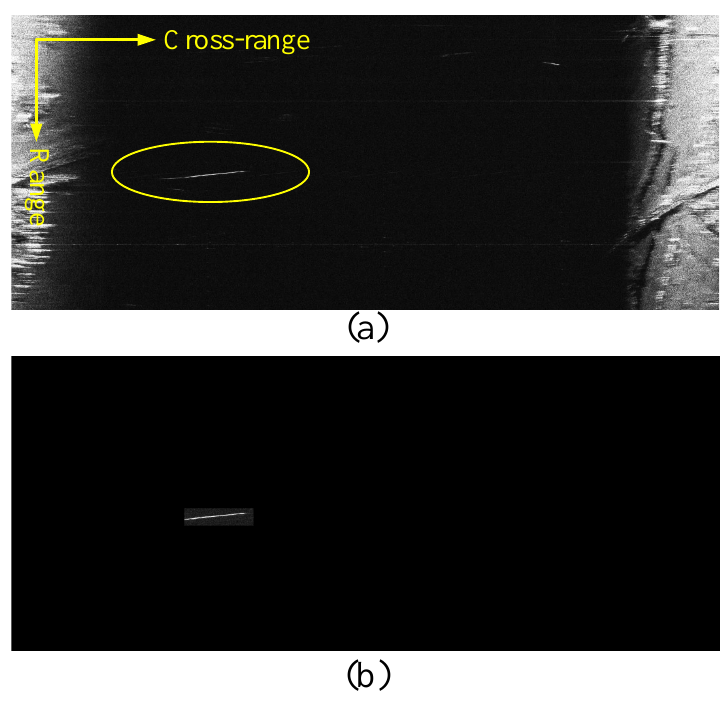
Figure 14. Moving target detection for T3. ( a ) Range–Doppler domain. ( b ) Moving target detection re- sult.